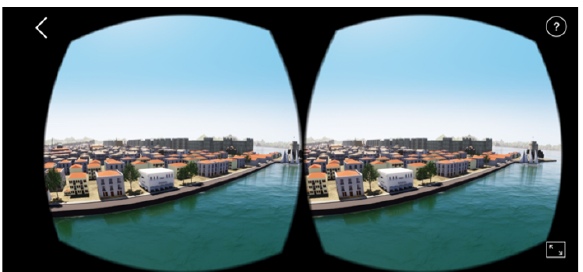
Figure 7. 3D visualization by using VR mobile applications of